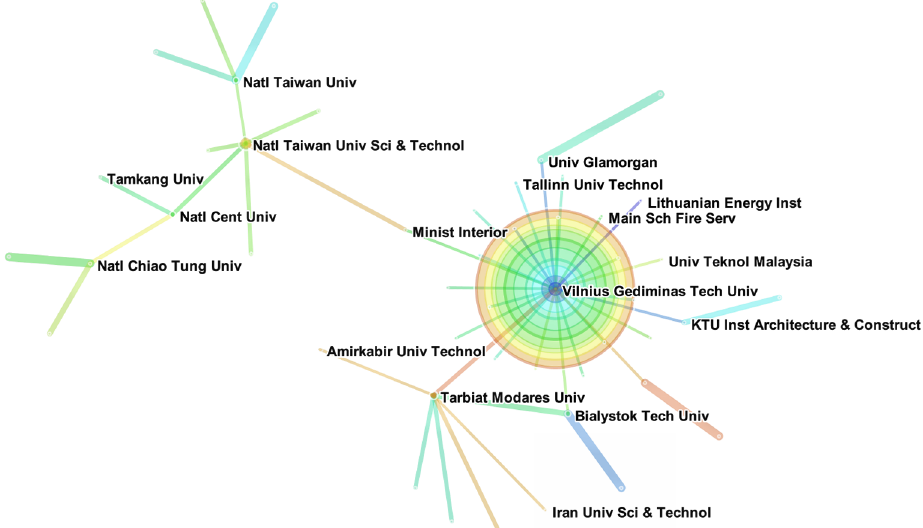
Figure 2. The biggest cooperation network at the institution